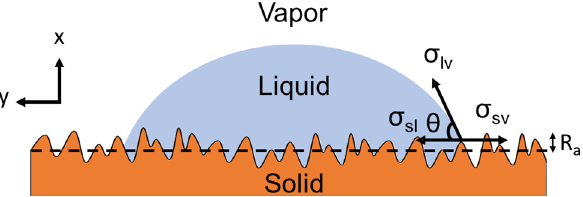
Figure 2. A schematic of a droplet on a flat surface showing three forces of surface tension leading to Young’s equation under static equilibrium on a rough